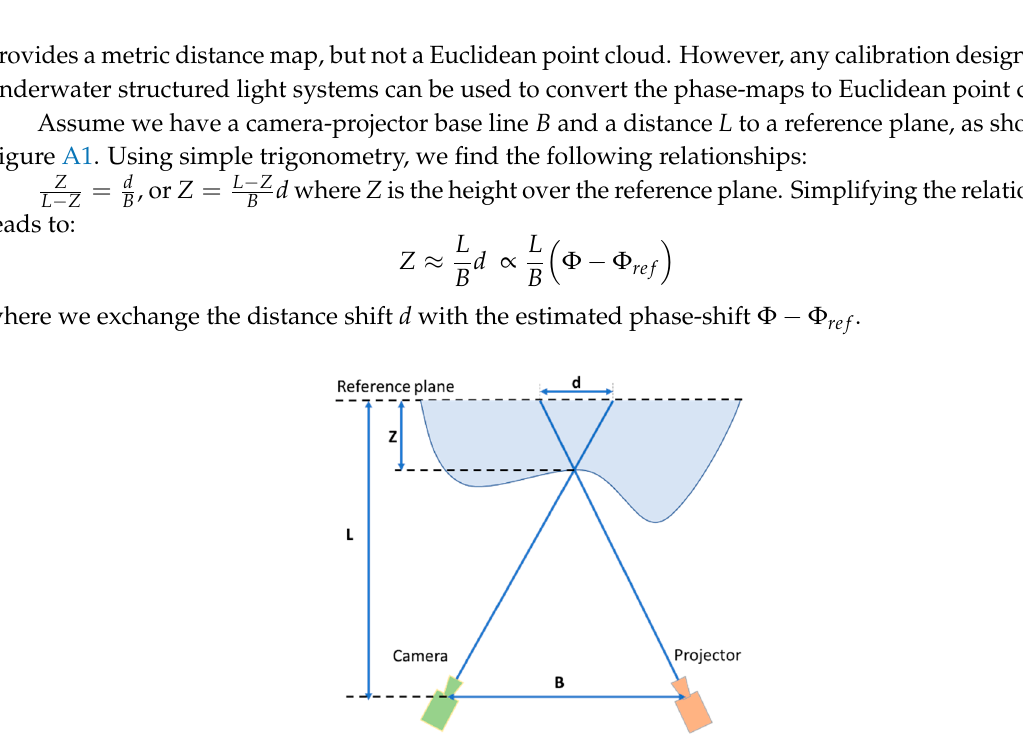
Figure A1. Overview of the calibration setup. The calibration uses the relative phase-shift between a reference plane and the object to compute the height Z.